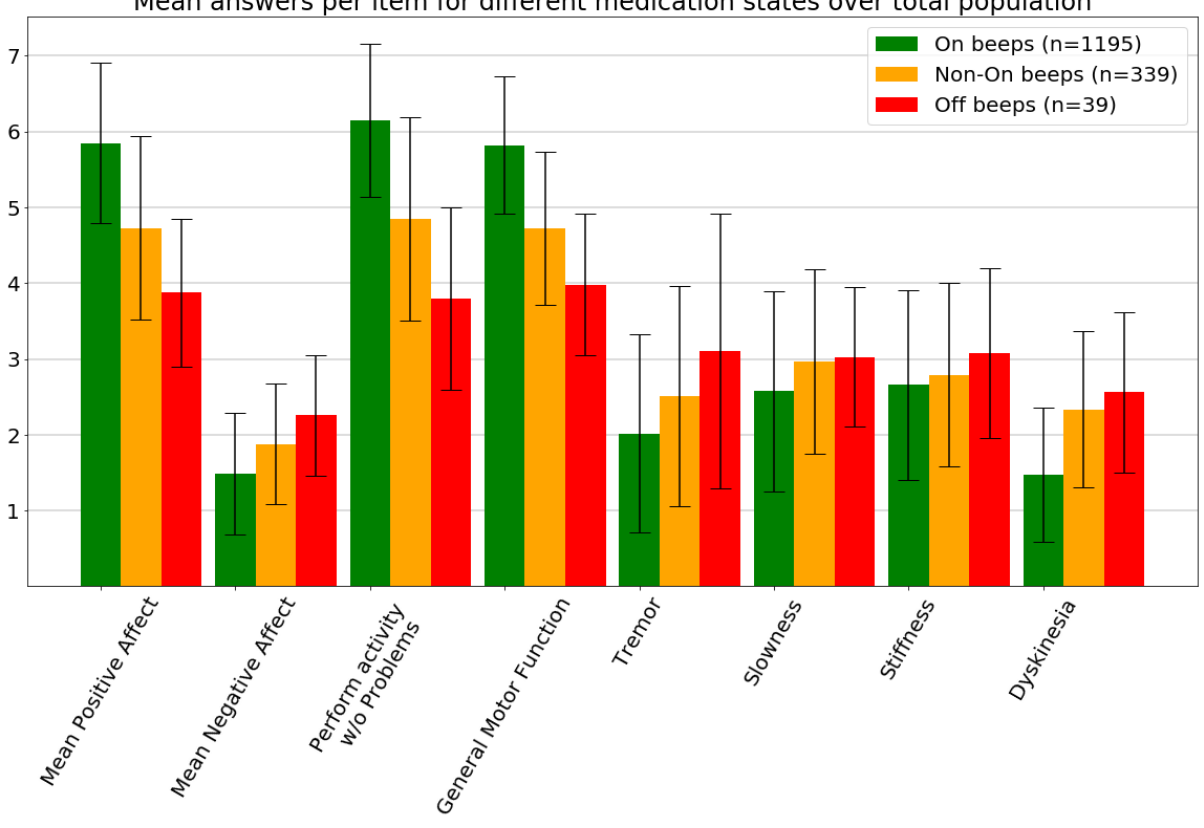
Figure 3. Mean answers during different medication states. The given answers in different medication conditions show significant differences. The direction of differences is as expected, except for dyskinesia, which is scored higher, on average, during off-condition compared with on-condition. Whiskers indicate standard deviations. On-beeps represent answers during on-medication, non–on-beeps represent answers during off-medication and during the transition phase, and off-beeps represent answers only during